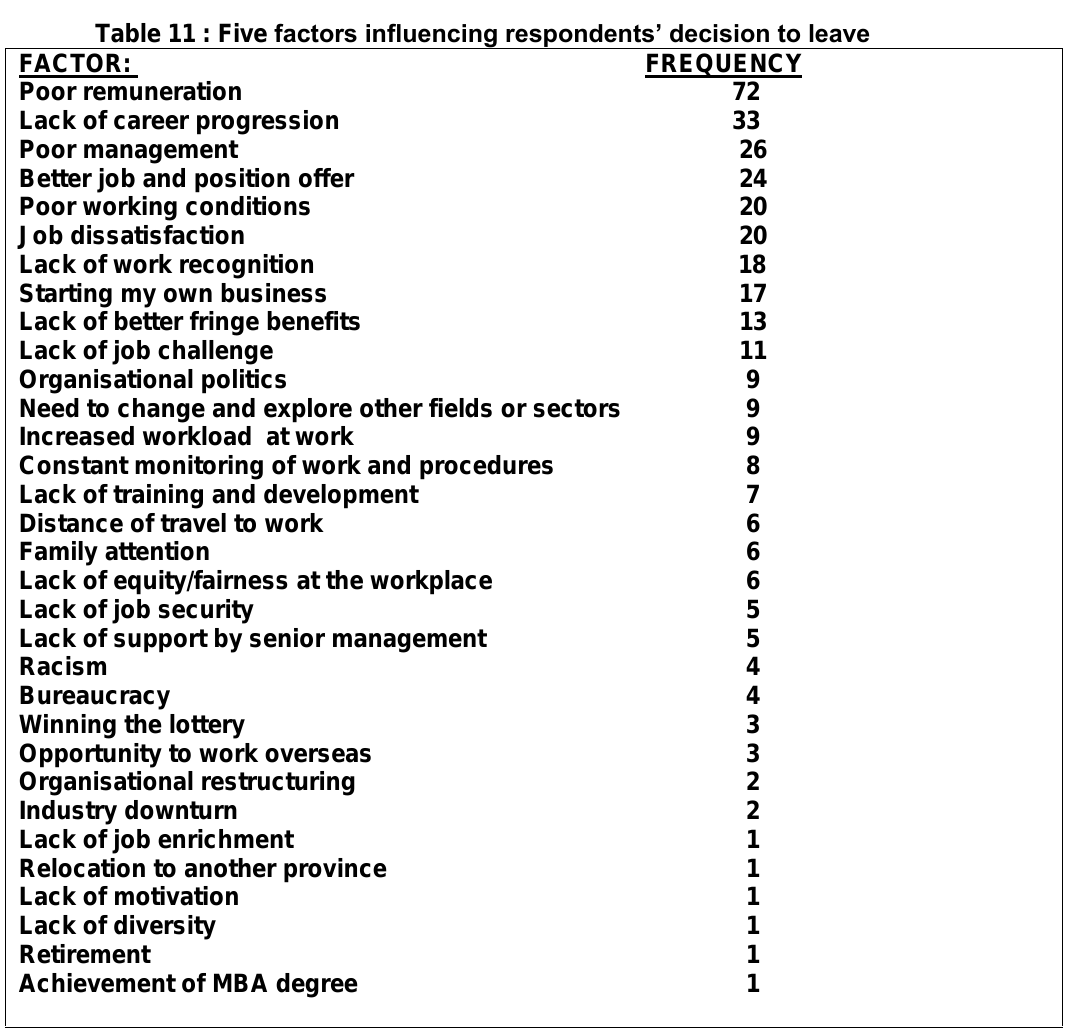
Table 11 : Five factors influencing respondents’ decision to